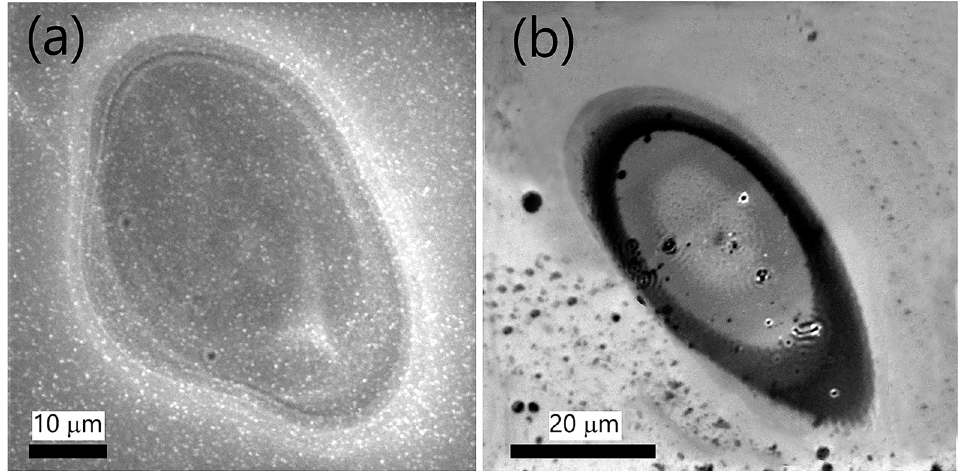
Figure 3. SEM micrographs of spot areas modified with a single linearly polarized femtosecond pulse of fluence 0.7 J/cm 2 and pulse duration ( a ) 38 fs and ( b ) 78 fs.